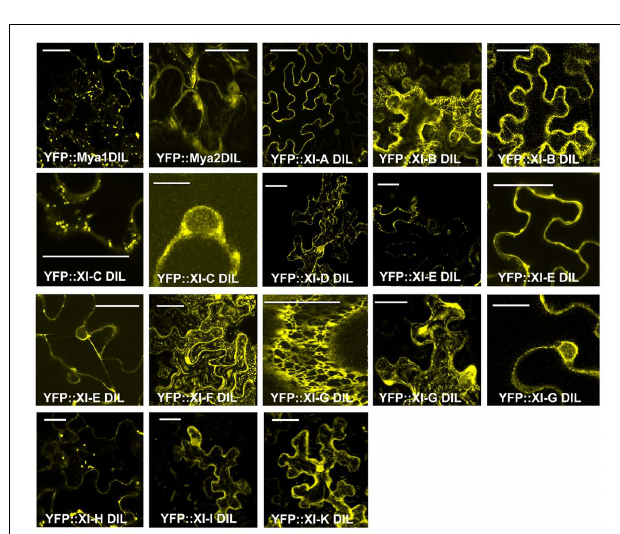
FIGURE 3 |Transient expression ofYFP fusions of A. thaliana class XI myosin DIL domains in epidermal leaf cells of N. benthamiana . Multiple images corresponding to cells expressing some of the DIL domain fusions are shown for those constructs that exhibited variation in expression patterns in different cells. Scale bar = 50 μ